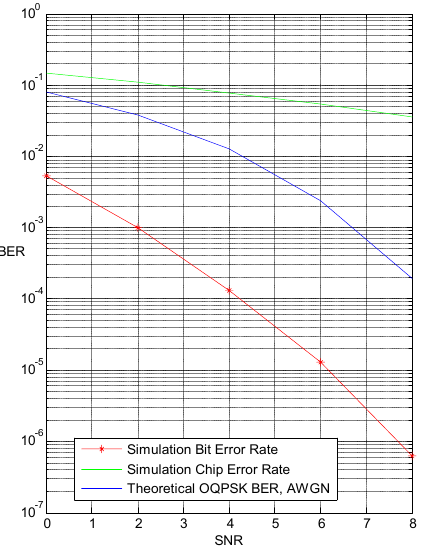
Figure 7. Fading channel and interleaver and deinterleaver are present on the